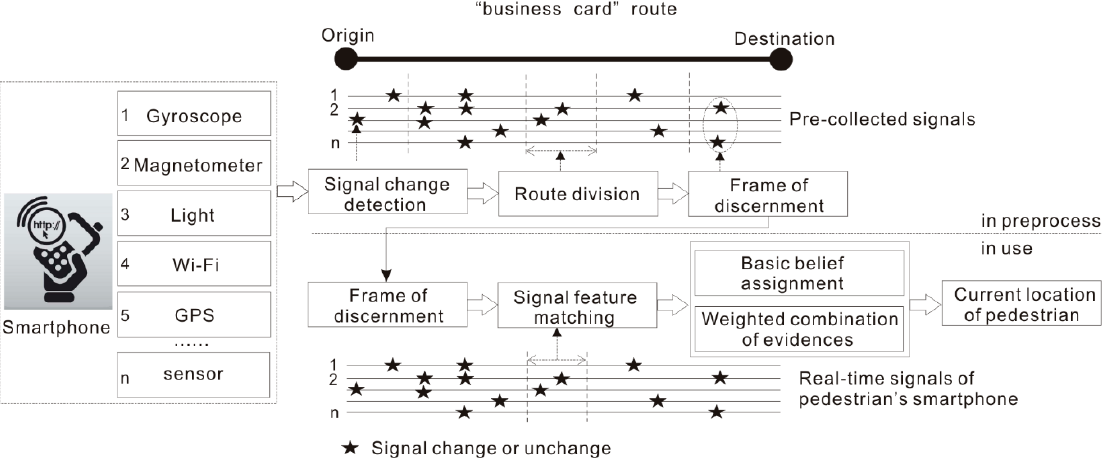
Figure 1. Framework of the proposed approach.